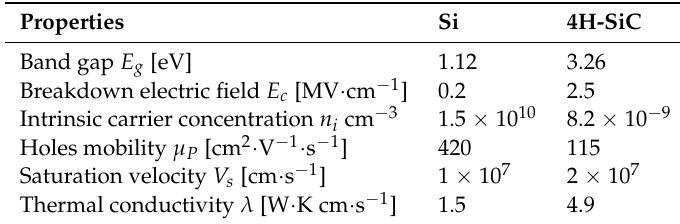
Table 3. Comparison between Si and WBG